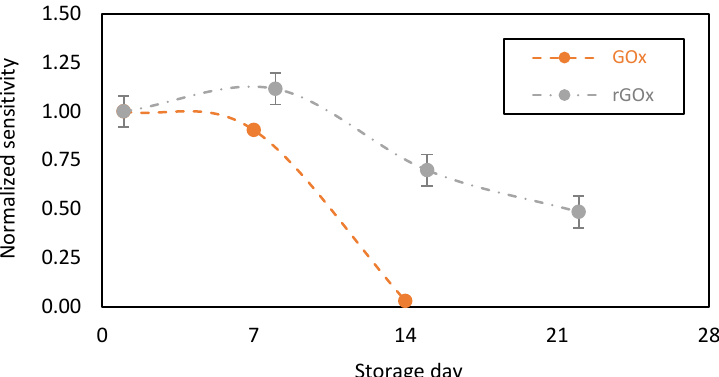
Figure 6. Stability in function of time of the chitosan-based biosensing membranes deposed on gold screen-printed electrodes and stored in PBS + glucose (2 mM) at 37 °C. Orange plot: normal Gox, and grey plot: recombinant rGOx (average value and standard deviation on 2 sensors).